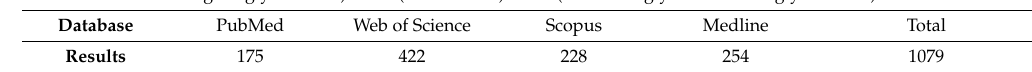
Table 2. Search criteria and initial results. These specific terms were used to search four databases, with the number of results yielded stated. HGI, high glycaemic index; GI, glycaemic index. (“high glycemic*” OR “high glycaemic*” OR “high-glycemic*” OR “high-glycaemic*” OR “HGI” OR “H-GI” OR “H GI” OR “high GI” OR “high-GI” OR “simple carbohydrate*” OR “simple-carbohydrate*” OR Search Term